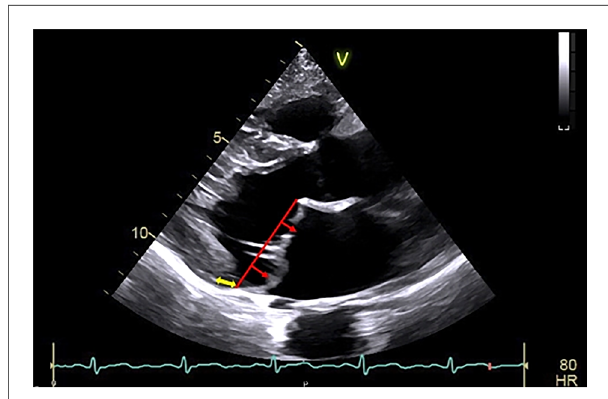
FIGURE 1 Arrhythmic mitral valve prolapse by transthoracic-echocardiography. Transthoracic-echocardiographic long-axis view in end-systole with a displacement of both lea fl et >2 mm (red arrow) above the plane of the annulus (red line) de fi ning a bilea fl et mitral valve prolapse with thick lea fl ets linked to myxomatous degeneration. Note the presence of the detachment of the posterior lea fl et from the left-ventricular myocardium (mitral annular disjunction, yellow arrow) to be assessed in dynamic analysis (that is a frame by frame analysis during the entire cardiac cycle) to better ascertain the position of the posterior mitral